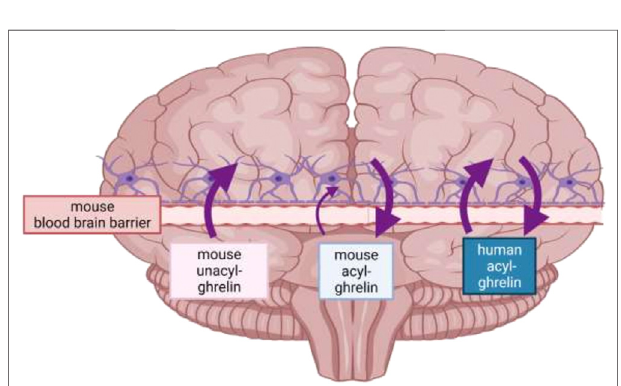
FIGURE 3 | Direction of travel of human acyl-ghrelin, mouse acyl-ghrelin and mouse unacyl-ghrelin across the mouse BBB. Mouse acyl-ghrelin predominantlycrossesthemouseBBBinthebrain-to-blooddirection,mouse unacyl-ghrelin is transported only in a blood-to-brain direction, whilst human acyl-ghrelin, which differs from mouse ghrelin at two amino acid residues is transported in both directions across the mouse BBB. As a result, ghrelin transport across the BBB is in fl uenced by at least two features of its structure-its amino acid sequence and post-translational acylation (created with Biorender, adapted from Banks et al.,